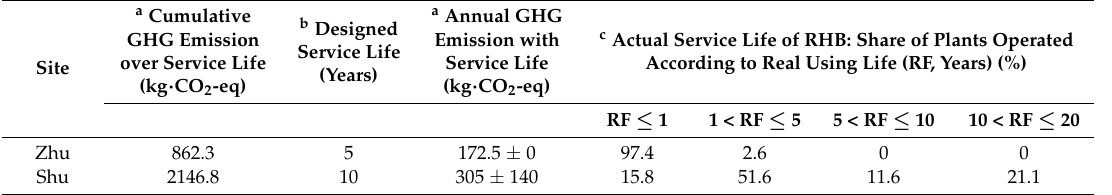
Table 2. Annualized GHG emissions from digester construction, expressed per household, and key data inputs used to calculate this compared against survey data on RHB operating life spans (up to the survey date).